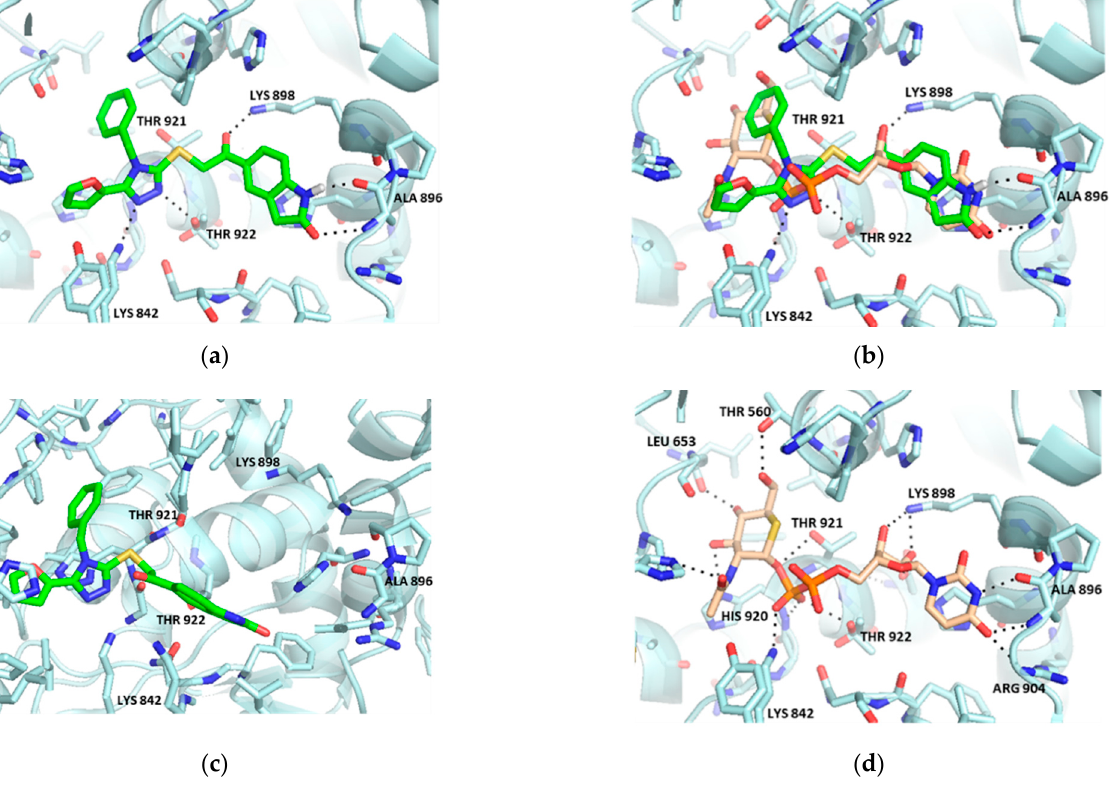
Figure 2. Structures of ligands solved and docked in complex with OGT (PDB entry: 4GYY). ( a ) representation of Vs-51/ 1 (green); ( b ) representation of Vs-51/ 1 (green) overlaid with UDP-5S-GlcNAc (beige); ( c ) representation of the binding mode of Vs-51/ 1 during the last 30 ns of the molecular dynamics simulation; ( d ) representation of UDP-5S-GlcNAc (beige). The ligand and the neighboring protein side-chains are shown as stick models, colored according to the chemical atom type (blue, N; red, O; yellow, S; orange, P). Hydrogen bonds are indicated by black dotted lines.